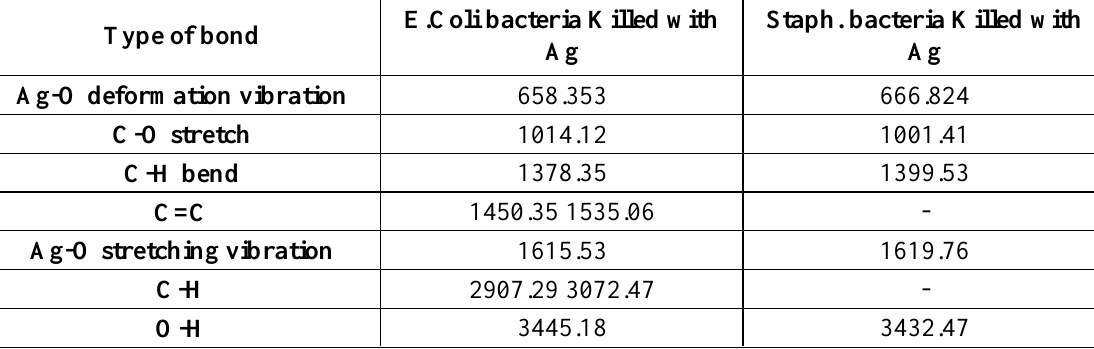
Fig. 6: FTIR pattern for (a) bacteria killed with Ag for E.coli. (b) bacteria killed with Ag for staph. sprayed on glass substrates with take part from dishes. Table 3: FTIR peaks for Ag film, E.coli, staph bacteria killed with Ag and Staph bacteria killed with